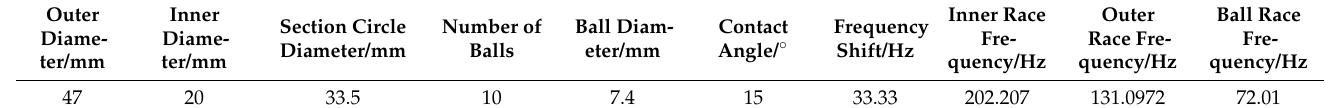
Table 3. The 7204C/P5 bearing parameters and failure frequency.